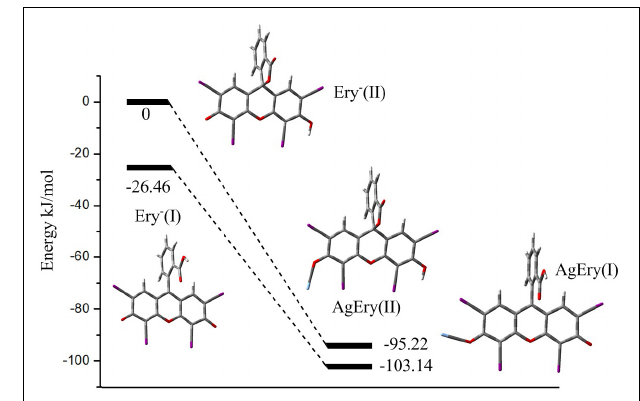
FIGURE 2 | Resonance Rayleigh scattering (RRS) spectra, concentration of erythrosine is 2.5 × 10 − 5 mol/l, pH = 4.4, concentrations of Ag(I) from curve i to vi are 0, 0.125, 0.250, 0.375, 0.500, and 0.625 µ g/ml.